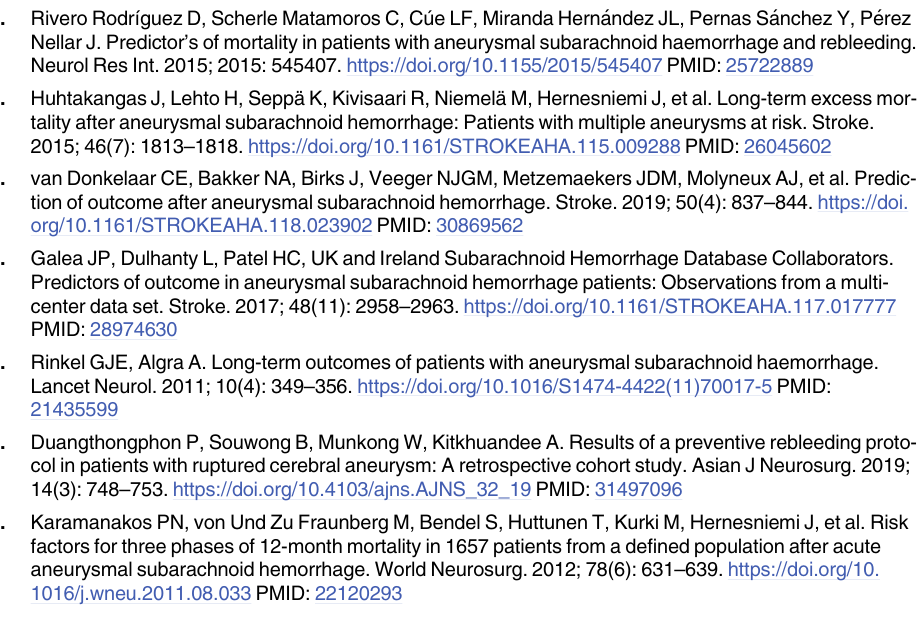
S1 Fig. Survival of patients by age groups. S2 Fig. Survival of patients by the World Federation of Neurosurgical Societies grading scale (WFNS) after resuscitation. (TIF) S3 Fig. Survival of patients by Modified Fisher scores (MFIS). (TIF) S1 Dataset. Aneurysmal subarachnoid hemorrhage data.